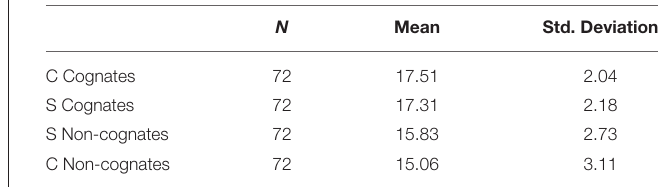
TABLE 4 | Mean scores on each experimental condition.